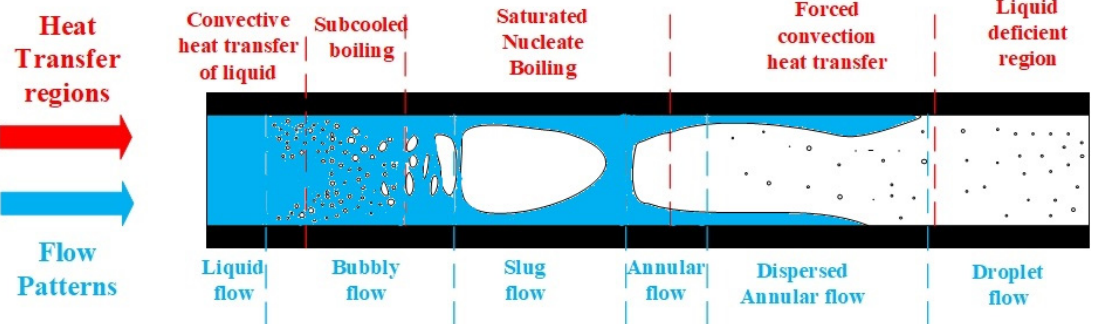
Figure 2. Schematic diagram of heat transfer regions and flow patterns in flow boiling over the horizontal tube.